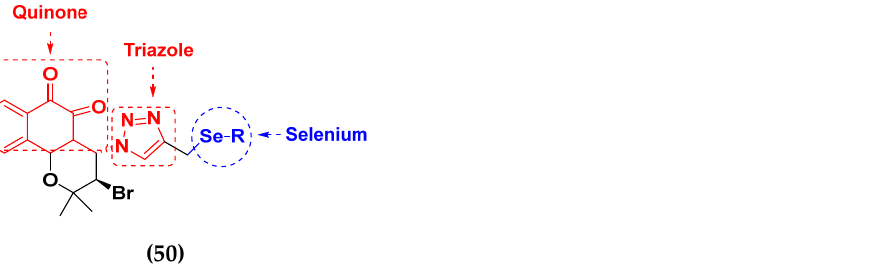
Figure 57. Structure of selenium-based quinone triazole hybrid derivatives ( 50 ).